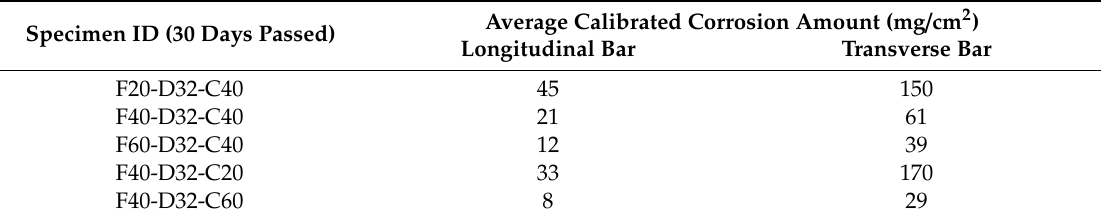
Figure 7. Surface condition of RC specimens after 30 days of accelerated corrosion testing. Table 5. Average calibrated corrosion amount for steel bar after 30 days of accelerated corrosion testing. Specimen ID (30 Days Passed)